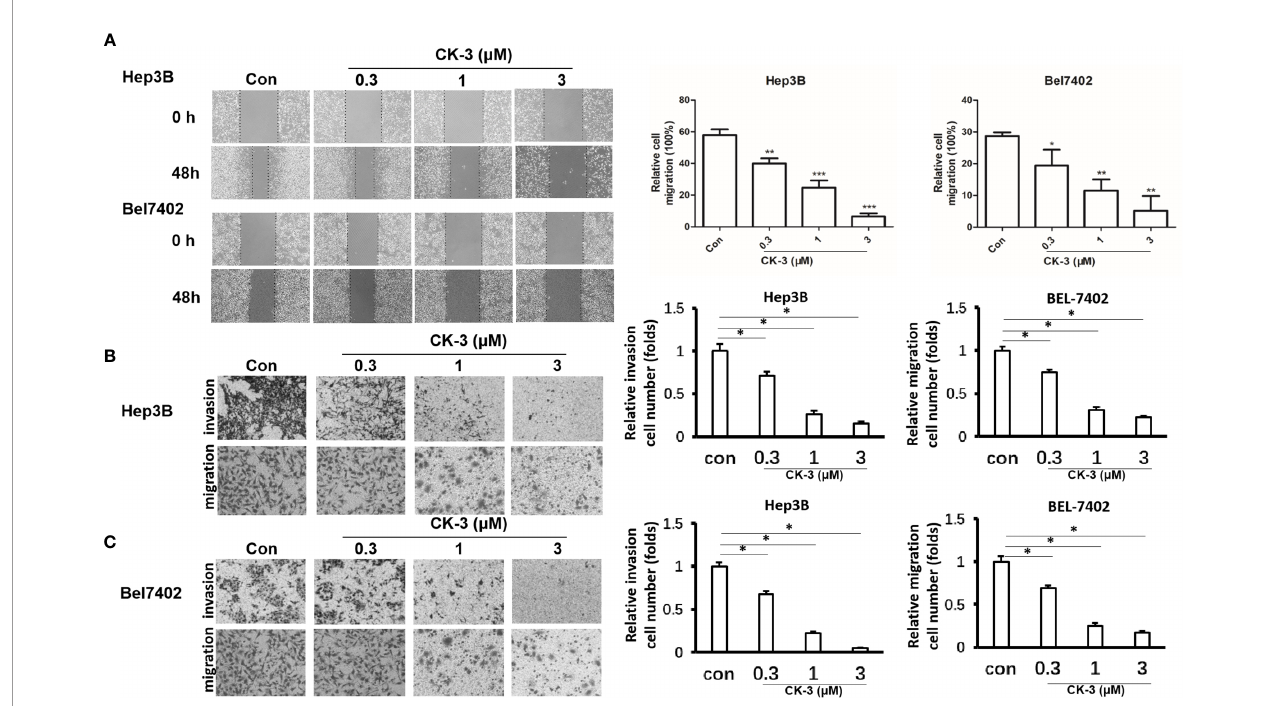
FIGURE 2 | Effects of CK-3 on Hep3B and Bel7402 cell migration and invasion. (A) CK-3 inhibited the migration of cells as demonstrated with a wound-healing assay. Dashed lines represent the edge of a wound. Micrographs were taken at 100x magni fi cation. (B, C) Inhibition effects of CK-3 on invasion/migration as demonstrated with a Transwell experiment. Stained cells were quanti fi ed by counting three random fi elds per Transwell. Micrographs were taken at 200x magni fi cation. * p < 0.05, ** p < 0.01, *** p < 0.001, compared with controls. CK-3 to inhibit PI3K activity in vitro ( Table 2 ). CK-3 selectively decreased after CK-3 ’ s treatment. In addition, CK-3 treatment inhibited the activity of the PI3K catalytic subunits PI3K a and resulted in a signi fi cant increase in the expression of PTEN, PI3K d . As indicated in Figure 3A , the expression of p-AKT which is an AKT pathway inhibitor ( Figure 3A ). Moreover, CK- (Ser473 point), p-mTOR and p-p70S6K1 (Thr389) was 3 could also inhibited the phosphorylation of ERK in HCC cells